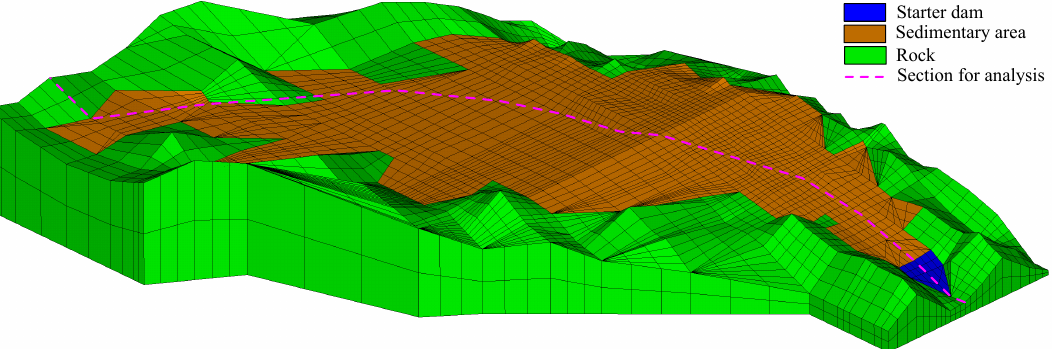
Figure 12. The 3d finite element mesh of the tailings dam with equivalent drainage structure. The equivalent drainage structure mesh of the section marked by the dashed line in this 3d mesh is the same as that in Figure 10. The tailings distribution in the sedimentary area is presented in Figure 10. The section is employed to analyze the seepage field in the tailings